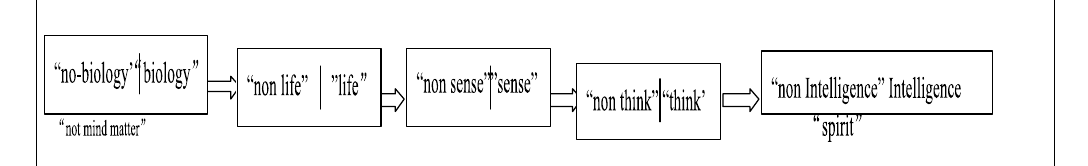
Figure 1. Basic contradiction between “matter” and “spirit” and a chain of secondary contradictions. Hsue-shen Tsien, a famous scientist from China, not only proposed noetic science and meta synthetic wisdom but also suggested an implementation scheme for MSW, notably, the Quantity Wisdom ⊗ Image Wisdom ⇒ Quality Wisdom (MSW), as shown in Figure 2a,b [3]. A Quantitative Method ⊗ Fixation Image Method ⇒ Qualitative Method (MSW) in which three arrows are added is proposed by attribute theory in this paper.